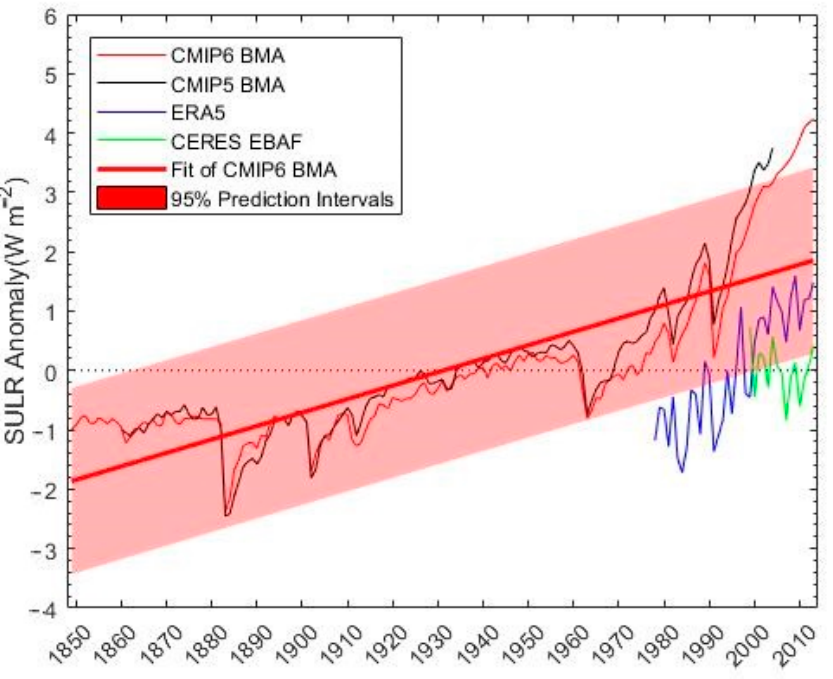
Figure 10. The annual variations in anomalous global mean SULR of the ERA5, CERES EBAF, and the BMA results of the CMIP6 and CMIP5 GCMs.